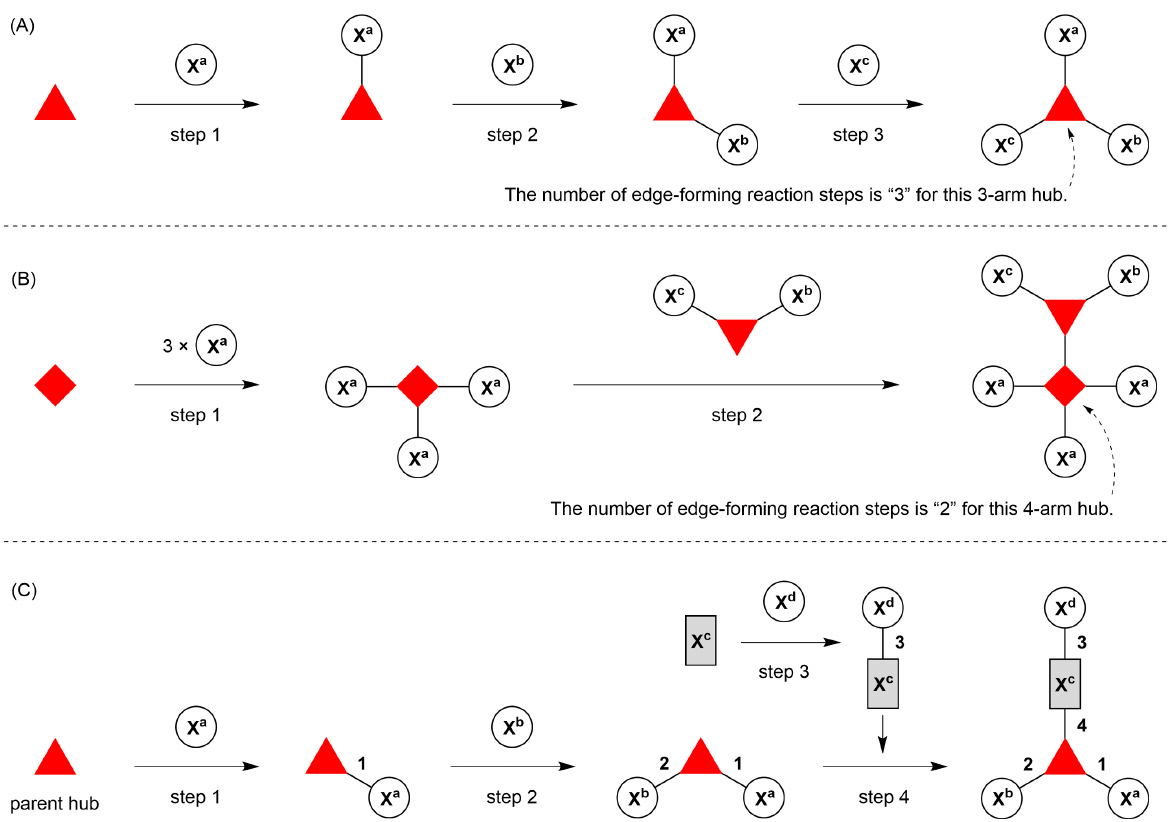
Figure 4. All graphs treated herein.